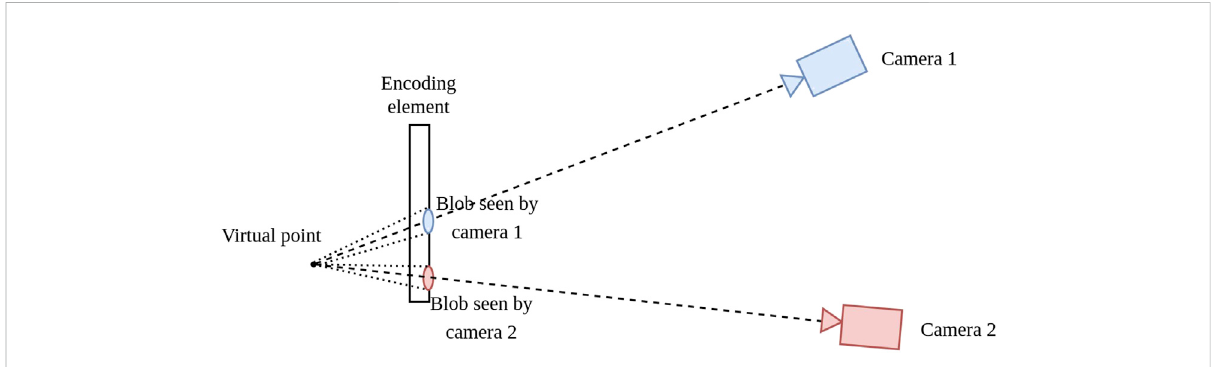
FIGURE 4 Workingprincipleofthevirtualpoint.Theencodingelementprojectsaphysicallocationinspaceatdepthontheimageplanewithoutrequiring an actual protrusion to that location.